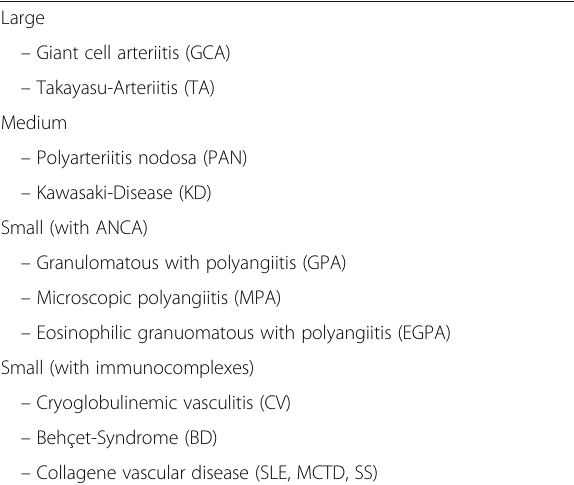
Table 1 Classification of Systemic Vasculitides according